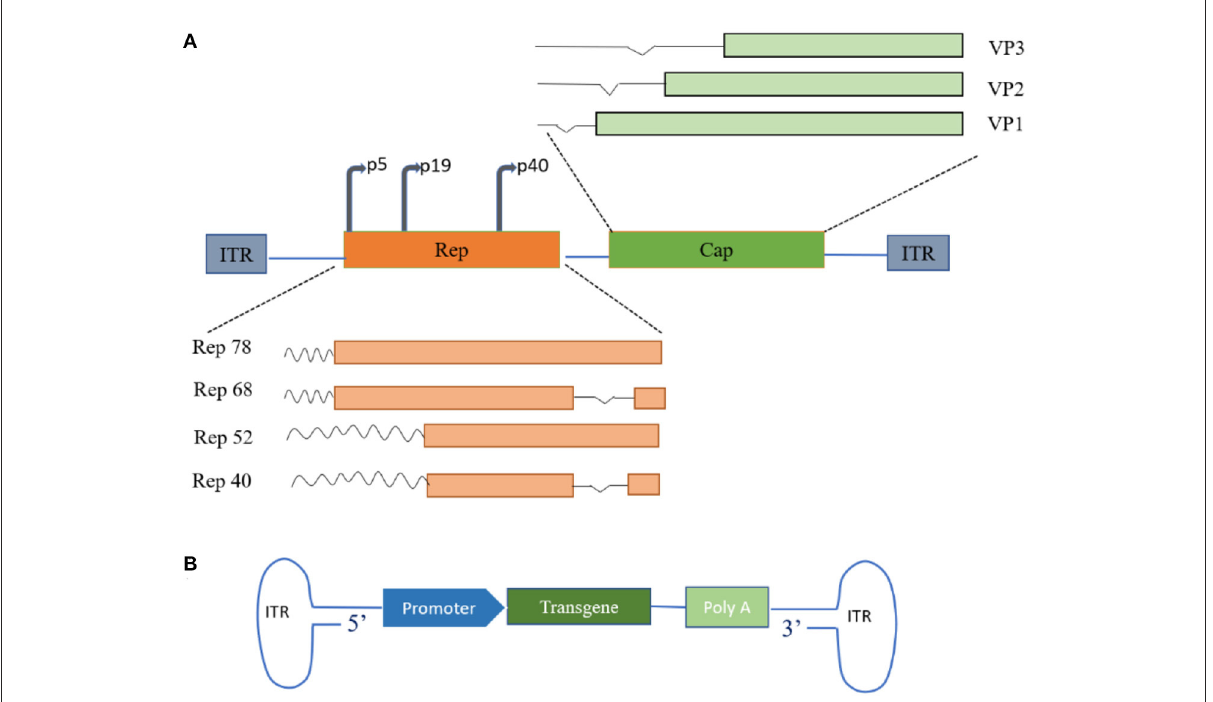
FIGURE1 Schematic of adeno-associated virus (AAVs) genome structure. (A) Wild-type AAV genome structure. The wild-type AAV comprises a small, unenveloped, single-stranded DNA genome of approximately 4.7Kb, encoding replication (Rep) and capsid (Cap) genes. Rep and Cap protein products are assembled into 60-polymeric viral capsids under suitable conditions. (B) Recombinant AAV genome structure. Therapeutic transgenes replace parts of the genome encoding proteins of the viral capsid. ITR, inverted terminal repeat; VP, capsid